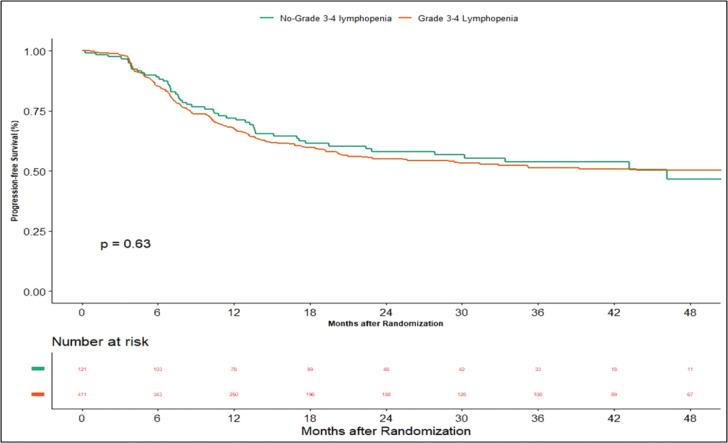
Kaplan–Meier curve showing progression-free survival in grade 3–4 and non-grade 3–4 lymphopenia.